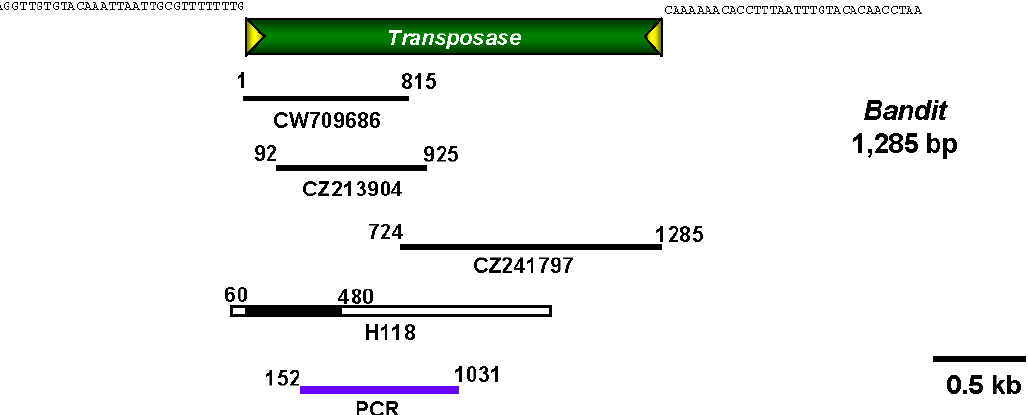
Figure 1. Schematic diagram representing clones and genomic survey sequences (GSS) from public databases which were used to assemble the consensus sequence of the bandit transposon from the genome of Ancylostomacaninum. Numbers on clones represent the nucleotide positions within the consensus, full length bandit sequence. GenBank accession numbers of contributing GSS clones are provided. The sequences of the terminal inverted repeats are presented in the top panel. In clone H118, the black colored region is bandit sequence whereas the white region on non-bandit encoding DNA.